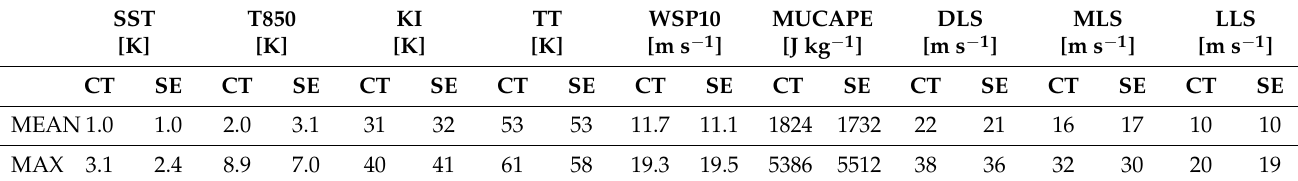
Table 2. Maximum values in the two sub-boxes. ”MEAN” indicates the averages of the maxima and “MAX” indicates the extreme